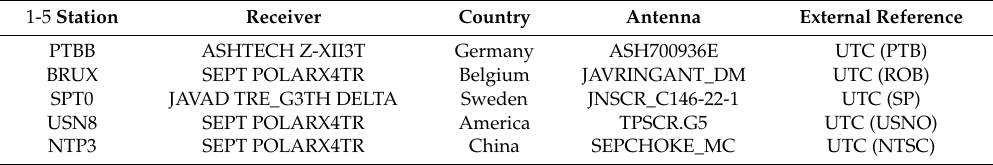
Table 1. Geodetic Stations and Associated Equipment forSelected Timing